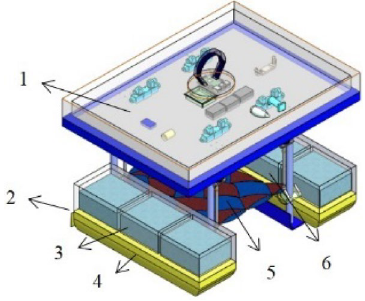
Figure 1. Conceptual model of the rescue robot.